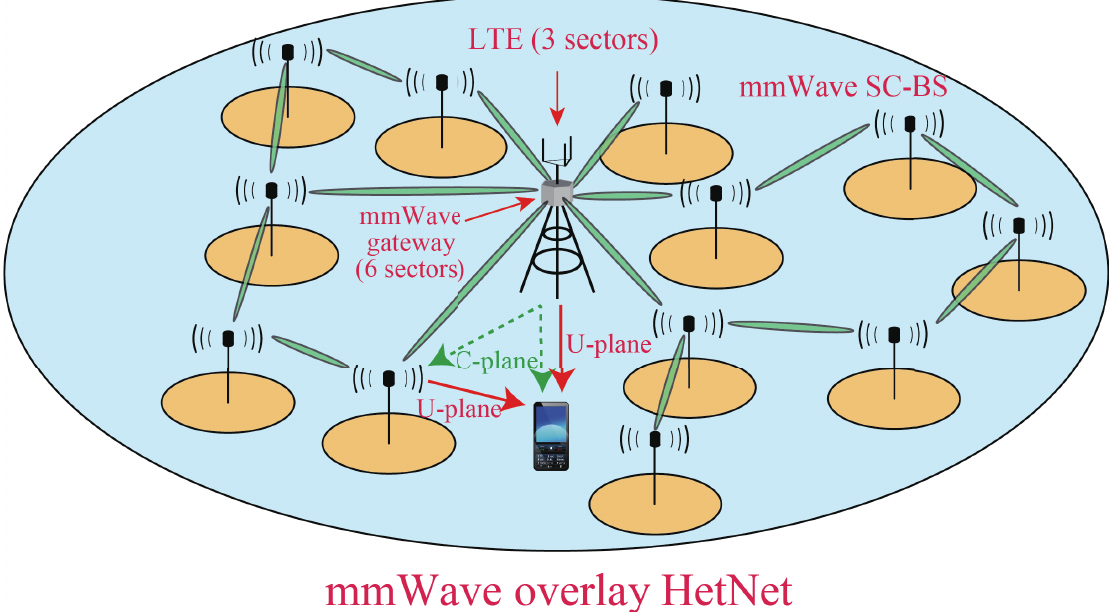
Figure 3. Self-backhauling mmWave overlay